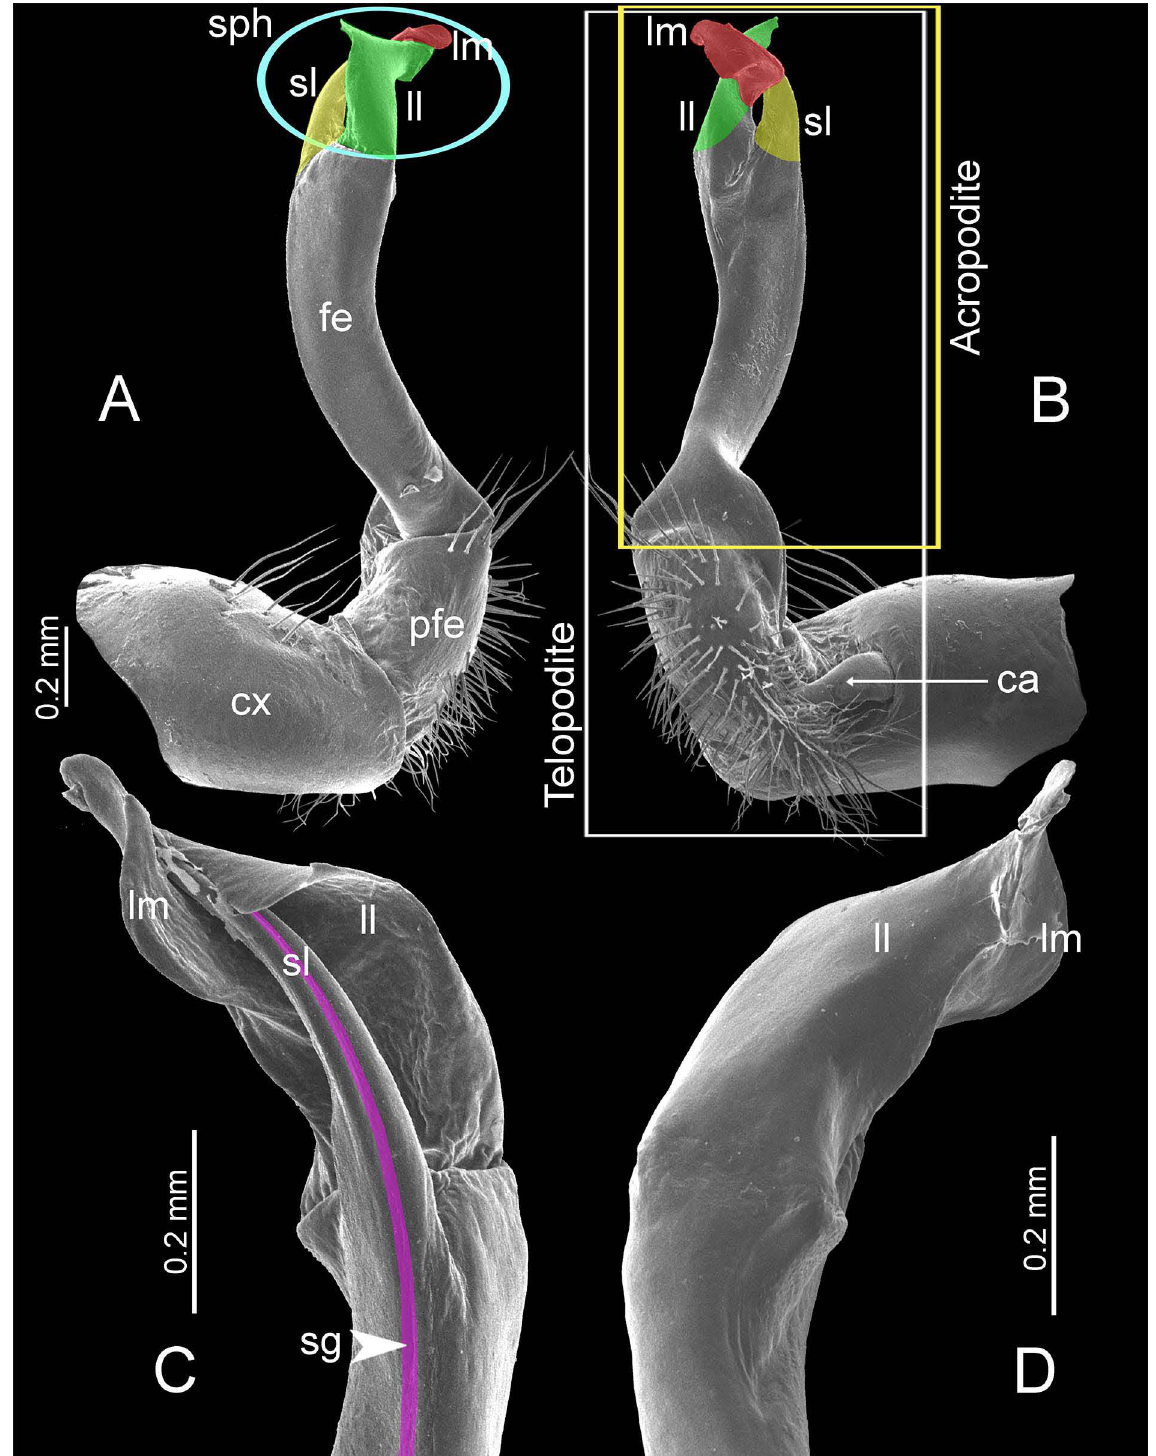
Fig. 3. SEM images of right gonopod of Gigaxytes Srisonchai, Enghoff & Panha gen. nov. – Gigaxytes gigas (Golovatch & Enghoff, 1994) gen. et comb. nov., ♂, specimen from Wat Tham Sue (Tiger Cave). A . Lateral view. B . Mesal view. C . Dorsal view. D. Ventral view. Colours: red = lamina medialis, yellow = solenomere, green = lamina lateralis, purple = seminal